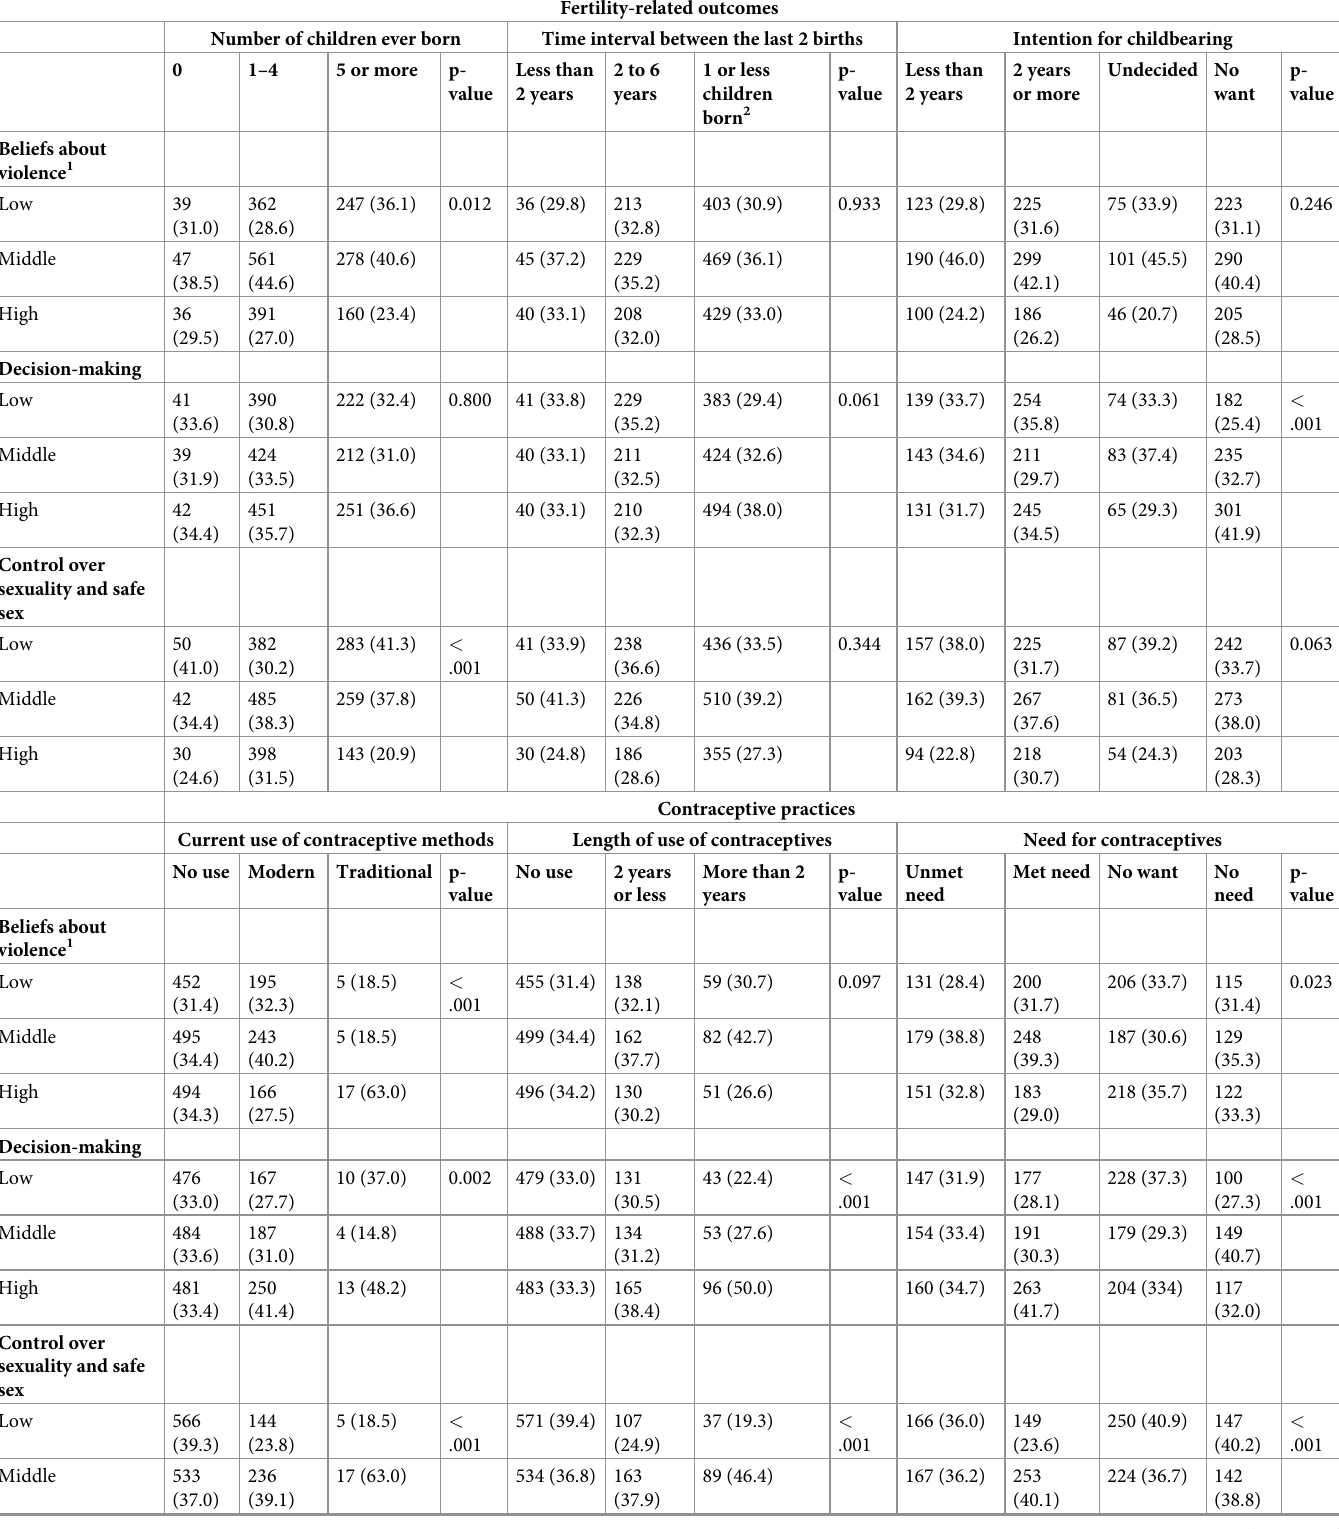
Table 3. Description of fertility–related outcomes and contraceptive practices by women’s empowerment domains in Mozambique. Fertility-related